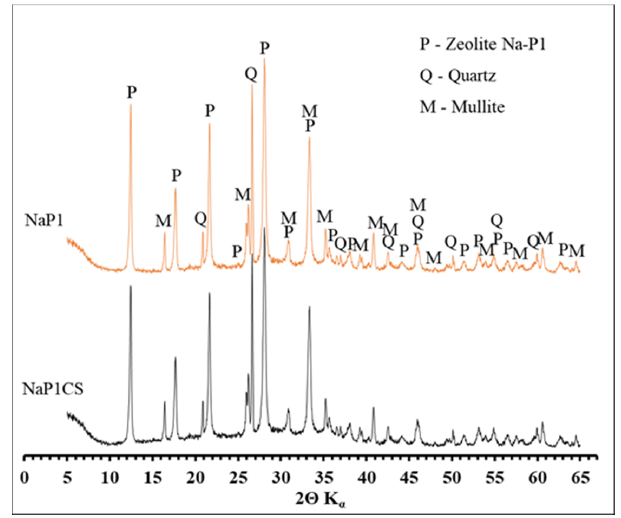
Figure 1. XRD patterns of NaP1 and NaP1CS.